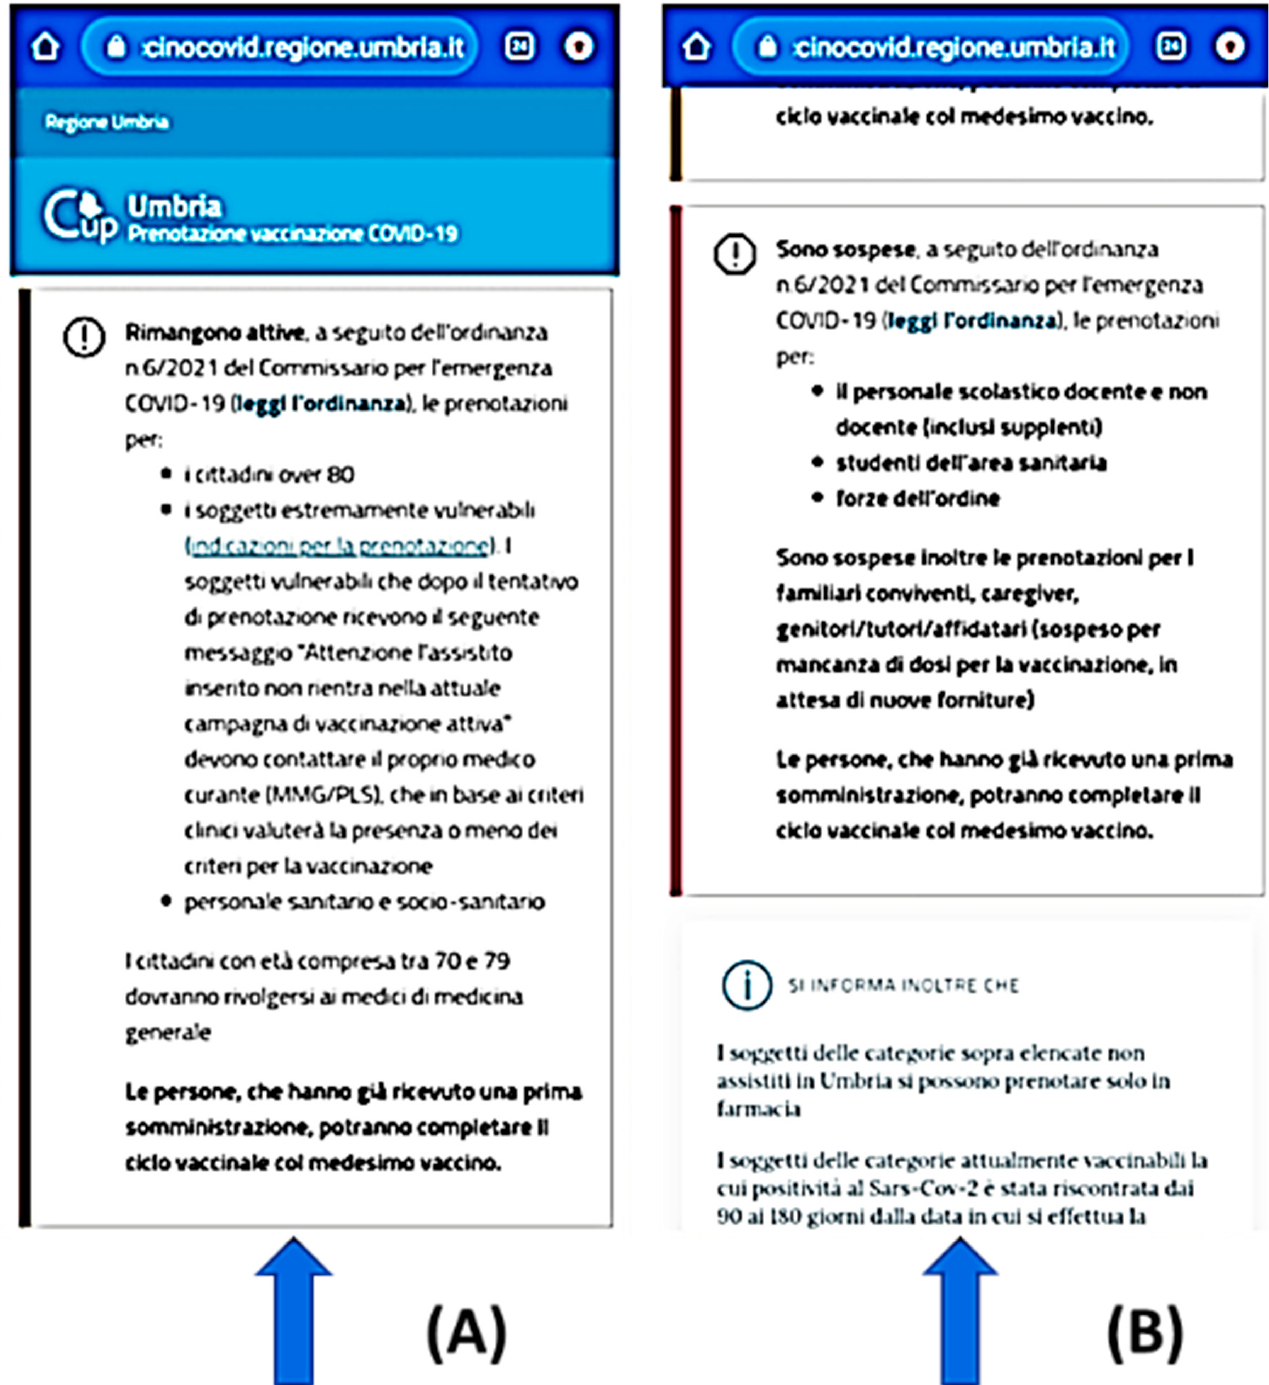
Figure 3. The message box highlights an example of the priority changes during the last spring following the legislative changes ( A ) (citizens over 80; frail people; personnel in the health domain). ( B ) Information on the changed priority during the submission (teachers, police and army personnel, care-givers and relatives of frails are excluded).